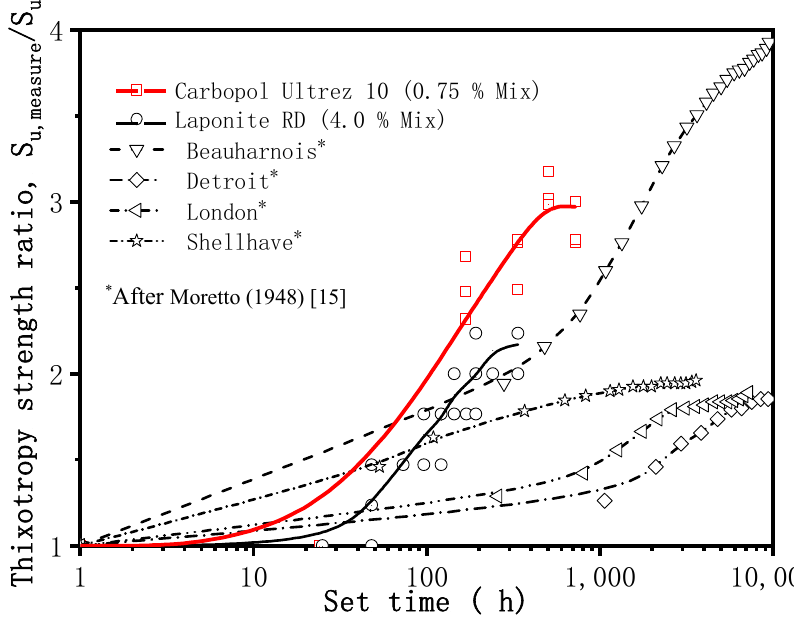
Figure 8. Thixotropy strength ratio for the synthetic transparent clay of a 0.75% initial mixture.